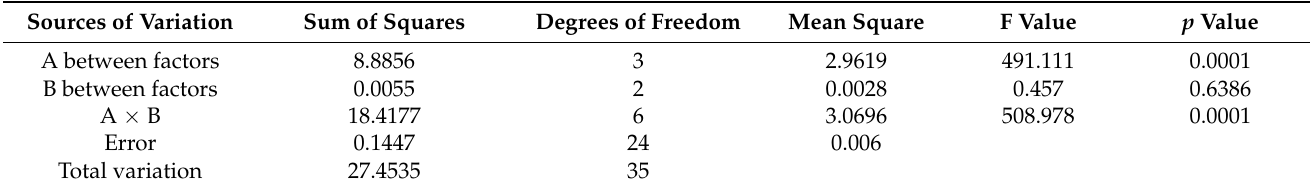
Table 2. Variance analysis of different cropping patterns